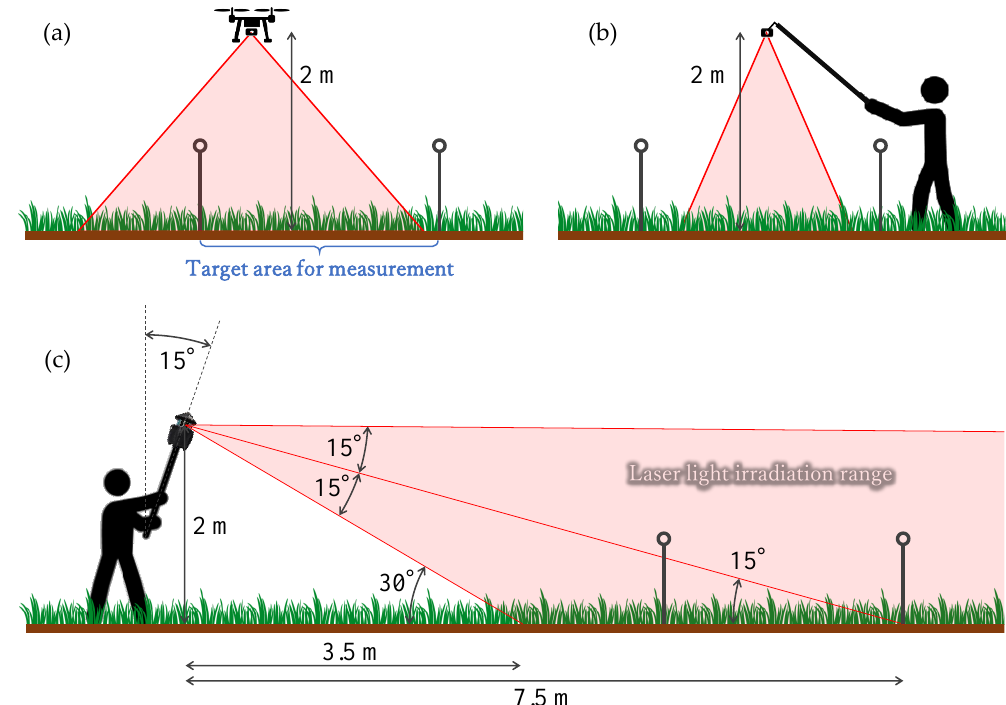
Figure 3. Schematic diagram of measurements: ( a ) unmanned aerial vehicle (UAV); ( b ) pole camera; and ( c ) light detection and ranging (LiDAR).